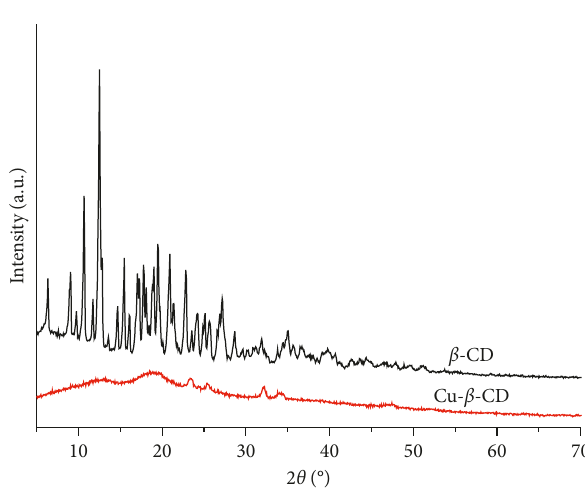
Figure 2: XRD patterns of pure β -CD and Cu- β -CD